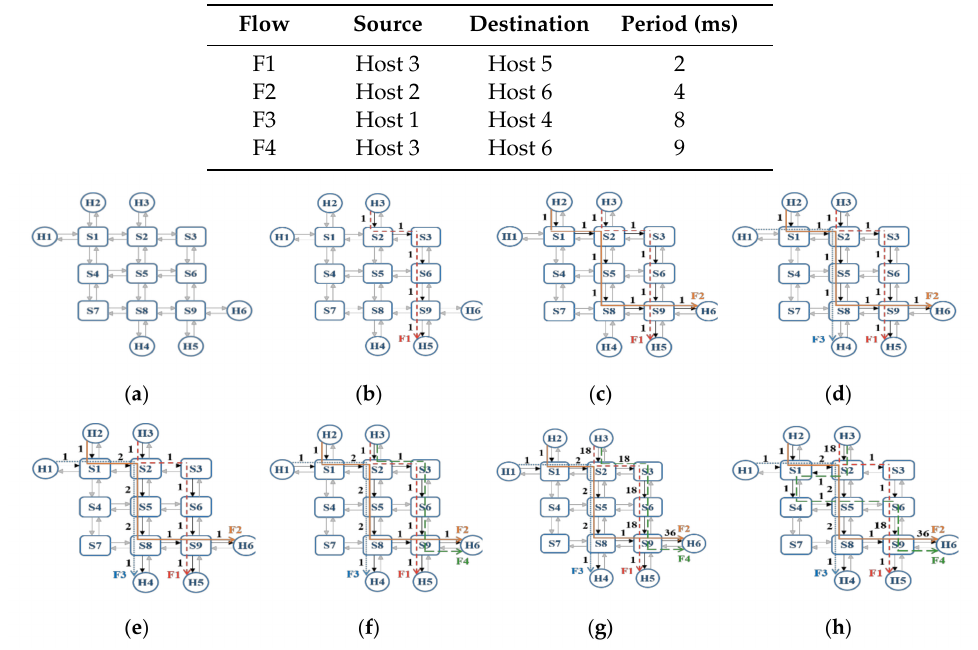
Figure 5. The example that illustrates the operation of the proposed algorithm. ( a ) The mesh topology with 9 switches and 6 hosts. ( b ) The shortest path of the flow F1. ( c ) The path with the minimum cost of the flow F2. ( d ) The result of routing the flow F3 with visited nodes, source node, and the destination node. ( e ) The result of updating the weight of each edge along the path of flow F3. ( f ) The result of routing the flow F4 with visited nodes, the source node, and the destination node. ( g ) The result of computing the weight of each edge where the flow F4 passes through. ( h ) The result of rerouting the flow F4 with all nodes in the